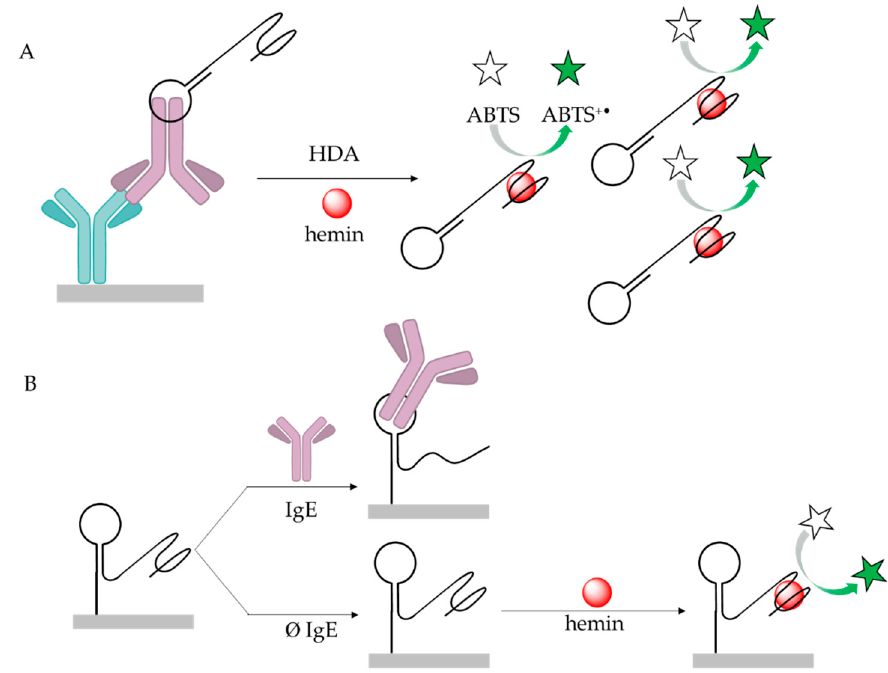
Figure 5. Sandwich assay based ( A ) and direct ( B ) colorimetric methods coupled with peroxidase activity of DNAzymes [98,99]. activity of DNAzymes